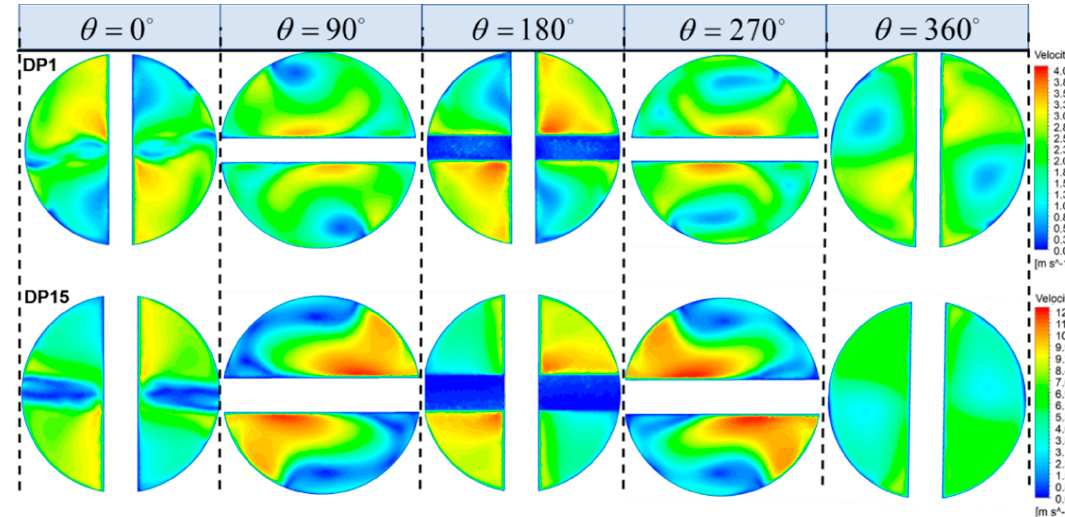
Figure 11. Velocity field simulation of five cross-sections in a couple of elements of DP7 and DP15.